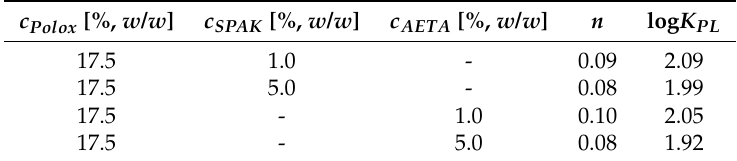
Table 1. Composition, flow index ( n ), and consistency index ( K PL ) of the hydrogel formulations containing SPAK or AETA with c Polox = 17.5% obtained from the viscosity curves using Equation (2) (see Section 4.2).